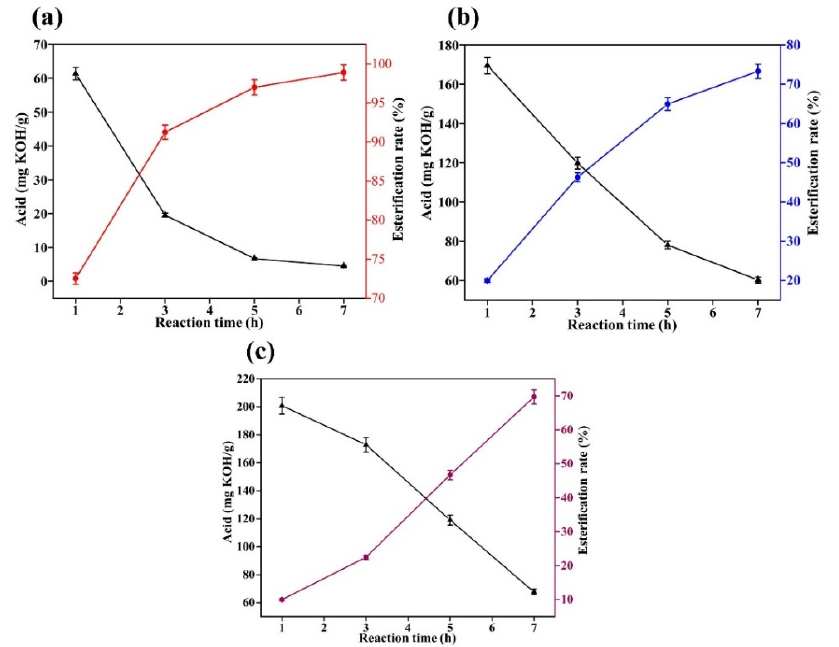
Figure 2. Catalytic esterification results of different catalysts ( a ): concentrated sulfuric acid; ( b ): sodium hydroxide; and ( c ): sulfamic acid.